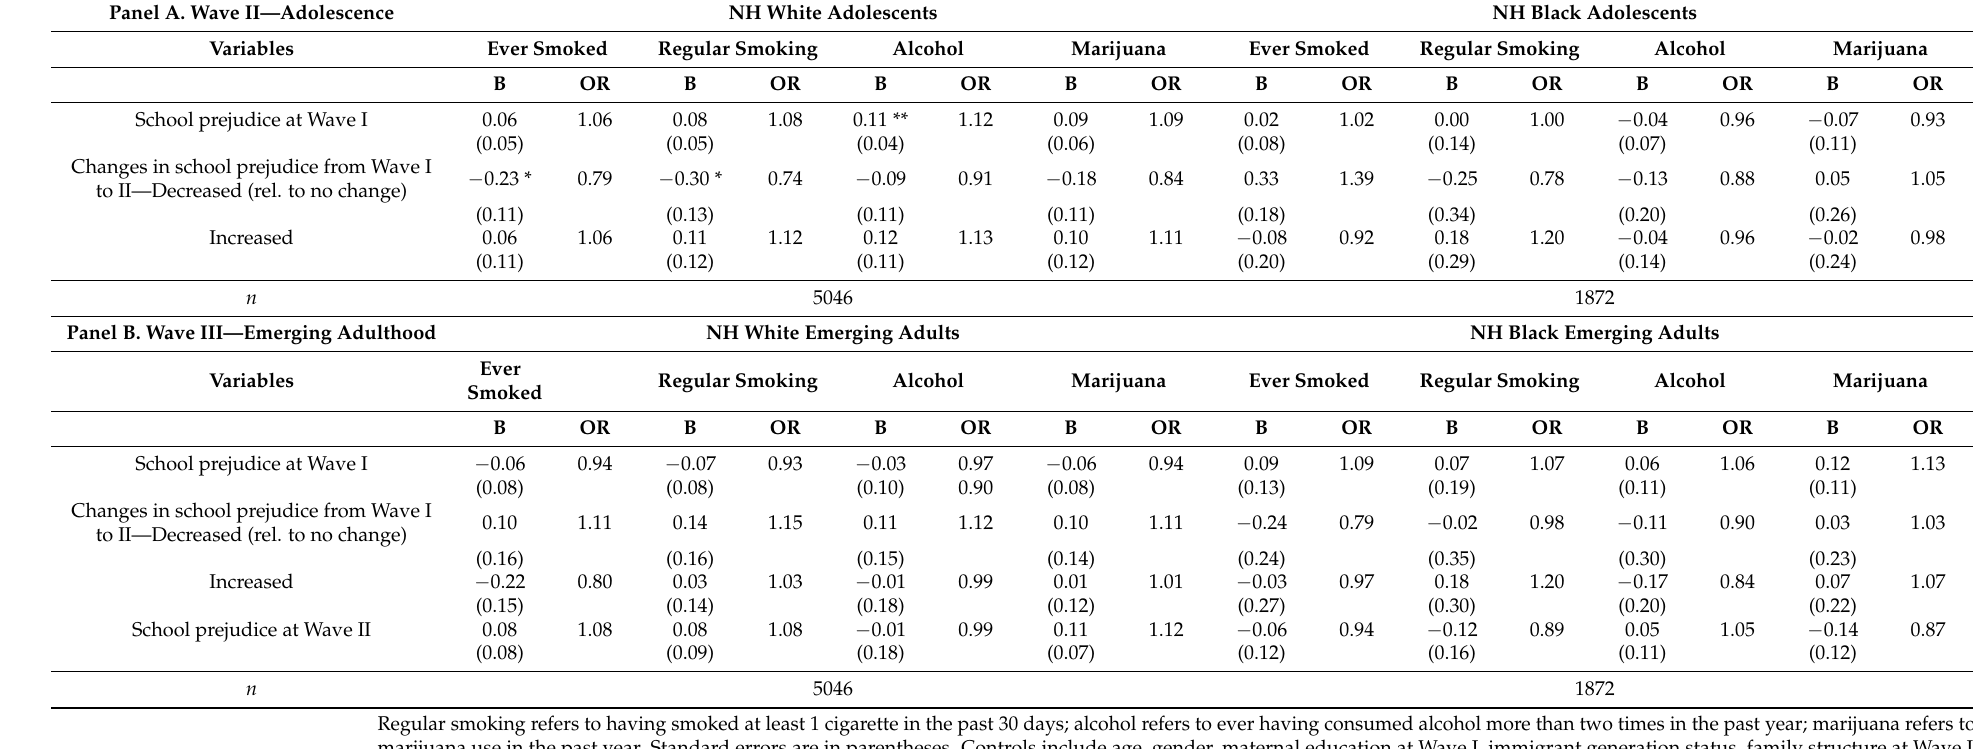
Table 4. Likelihood of substance use among White and Black adolescents at Waves II and